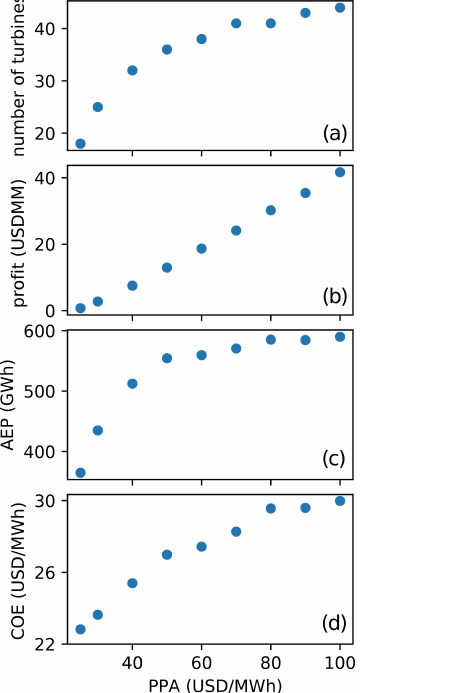
Figure 15. The effect of PPA on the optimal solution for wind power plants optimized for profit. From top to bottom are the num- ber of turbines, profit, AEP, and COE as a function of the